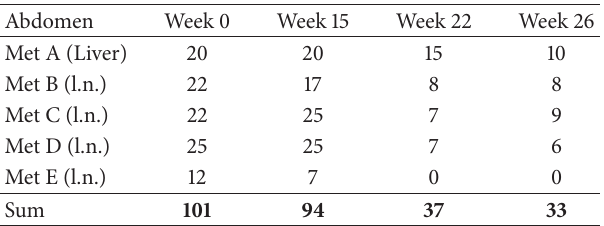
Table 1: Analysis of metastases during vaccination.